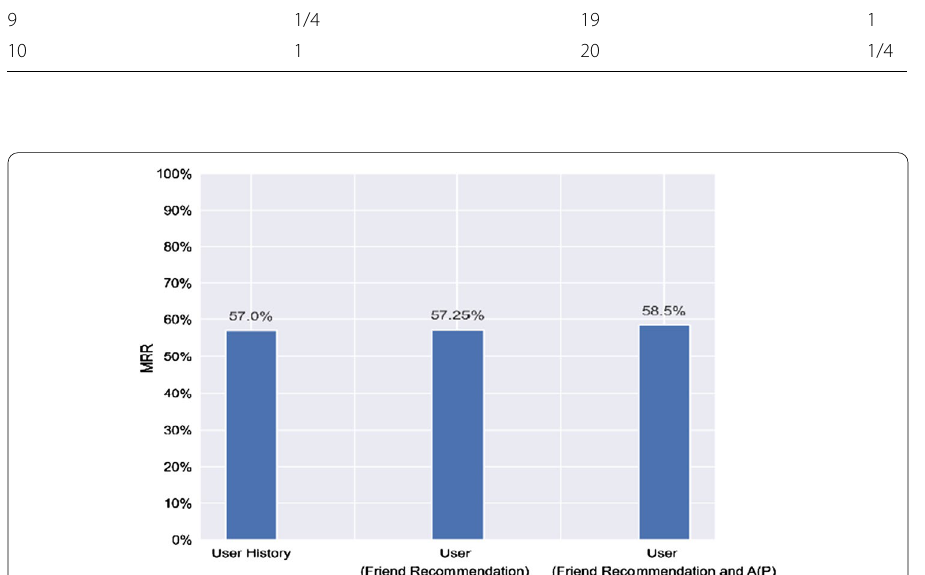
Fig. 8 Comparison of the MRR results: user history only, friend recommendation vs. friend recommendation and A(P)